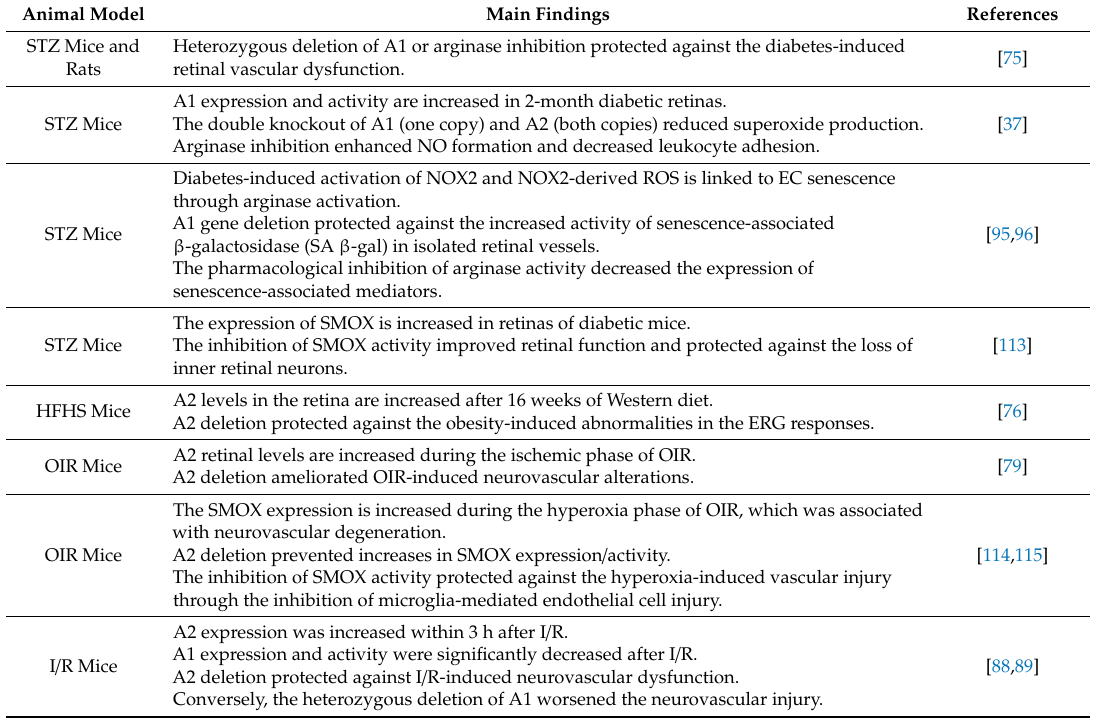
Table 1. Table summarizing the main findings about arginase and diabetic retinopathy (DR) in animal models of ischemic